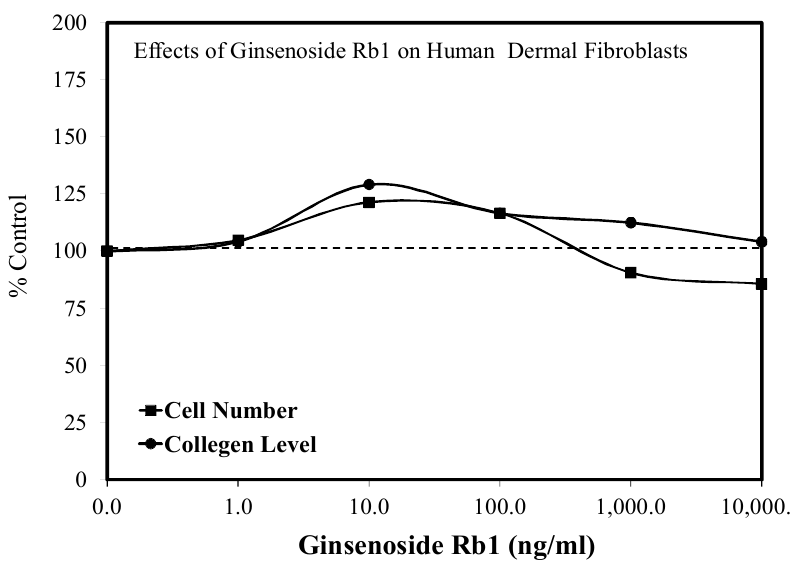
Figure 21. E ff ects of ginsenoside Rb1 on human dermal fibroblasts (source: [86]). Figure 21. Effects of ginsenoside Rb1 on human dermal fibroblasts (source: [86]).